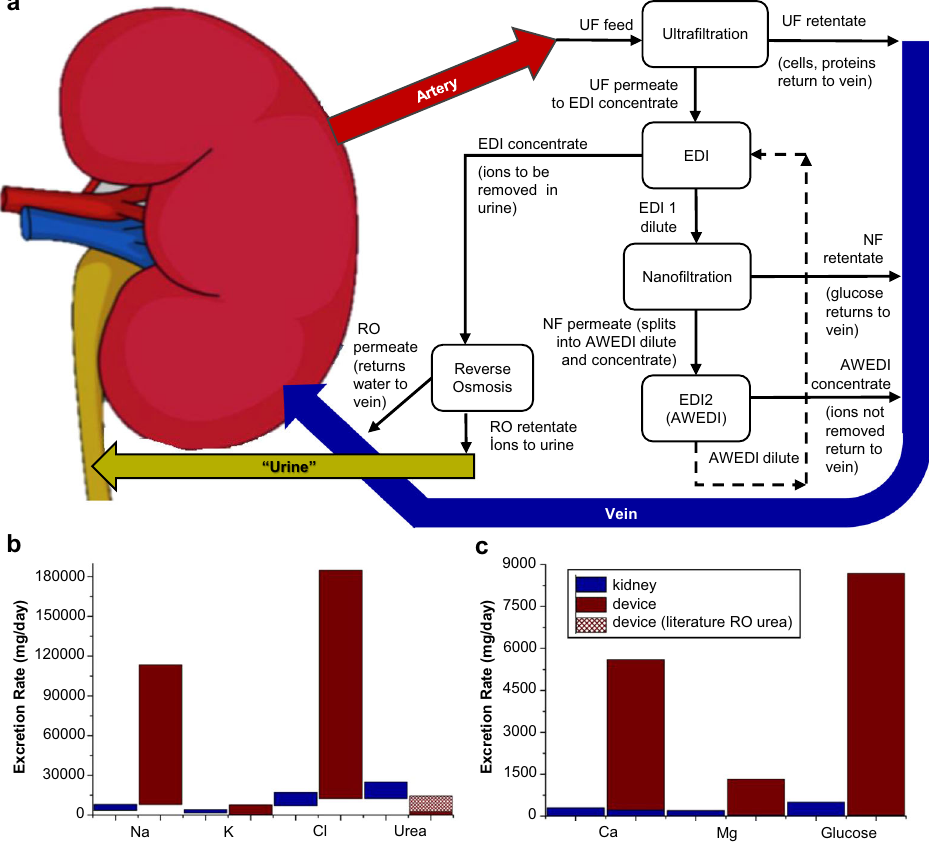
Fig. 4 Con fi guration and performance of the arti fi cial kidney device. a Various components of the arti fi cial kidney device. b , c Comparison of the composition of urine produced by a native kidney (blue) to arti fi cial urine produced by the arti fi cial kidney device (red). Device performance was calculated using experimental rejection values for ultra fi ltration (UF), nano fi ltration (NF), and reverse osmosis (RO) and selectivity values for electrodeionization 1 (EDI1) and electrodeionization 2 (EDI2) under different experimental conditions (transmembrane pressure, applied currents, fl owrates,